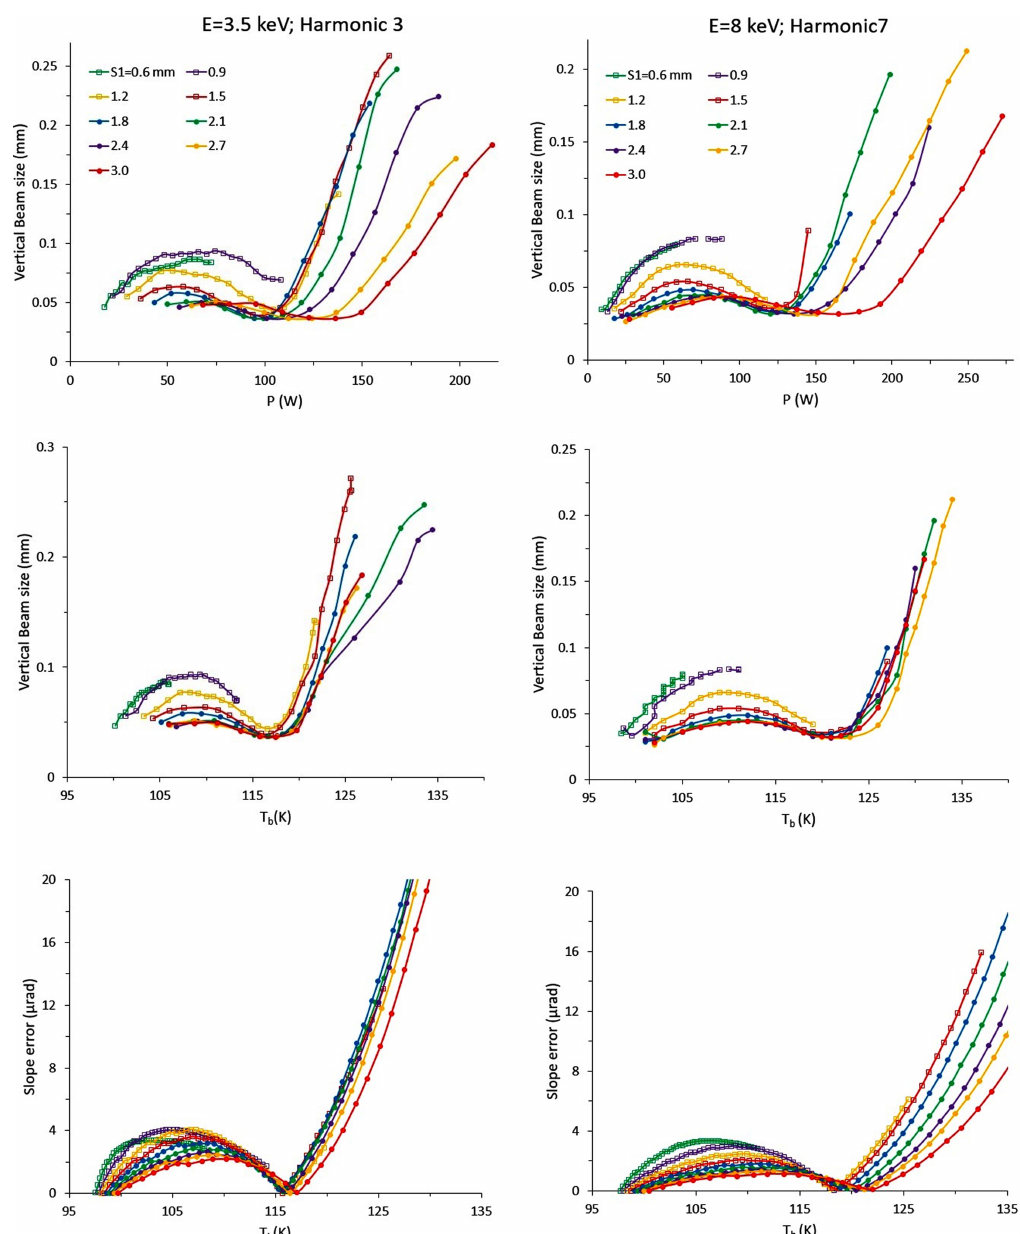
Figure 10 Measured vertical beam size at the focal position versus calculated power (top) and T b (middle) for typical power conditions. Bottom: slope error from the model in Section 2 at E = 3.5 keV (left) and 8 keV (right). Legends indicate the vertical opening of S 1